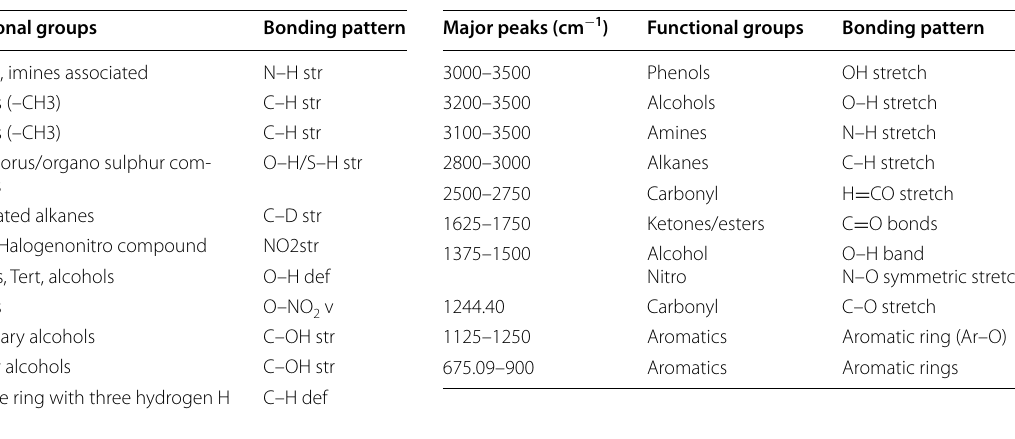
Table 4 FT-IR spectrum of Mentha spicata leaf extract. Source